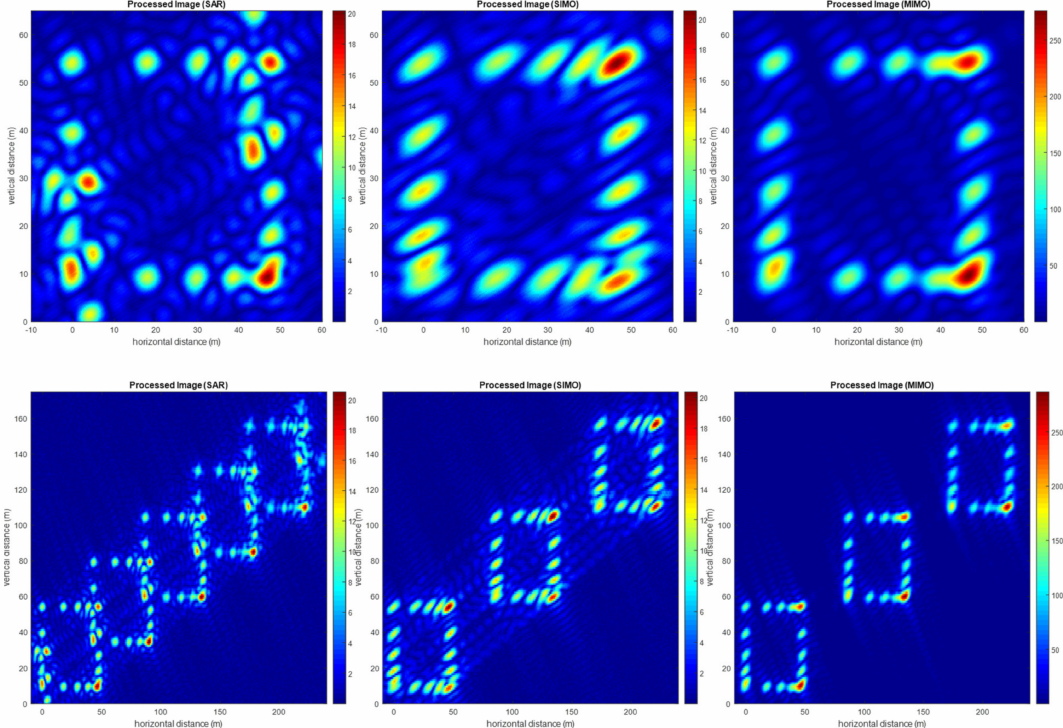
Figure 32. The simulated 2D images for Example 8 for SAR/SIMO/MIMO modes. Upper row: fine scene resolution (20 cm), small scene extent. Lower row: coarse scene resolution (1 m), large scene